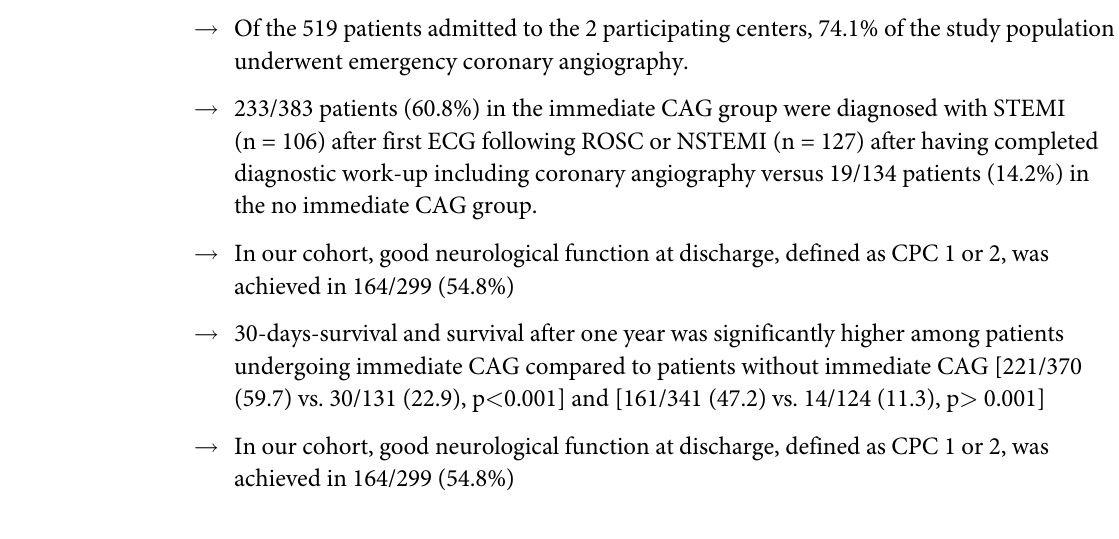
Fig 2. Forest plot with odds ratios and 95% confidence intervals of factors associated with 30-days-survival after propensity score-matched analysis.